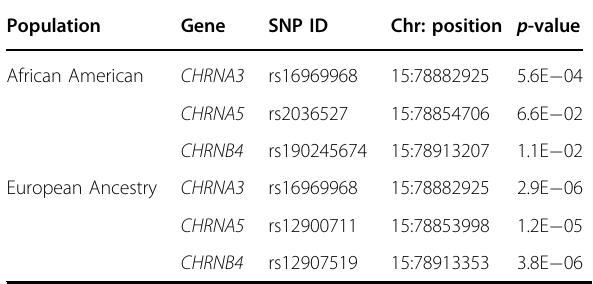
Table 4 Top-ranked associations of stimulant dependence with individual variants in each of three adjacent nicotinic acetylcholine receptor genes observed in the discovery GWAS in African American and European ancestry